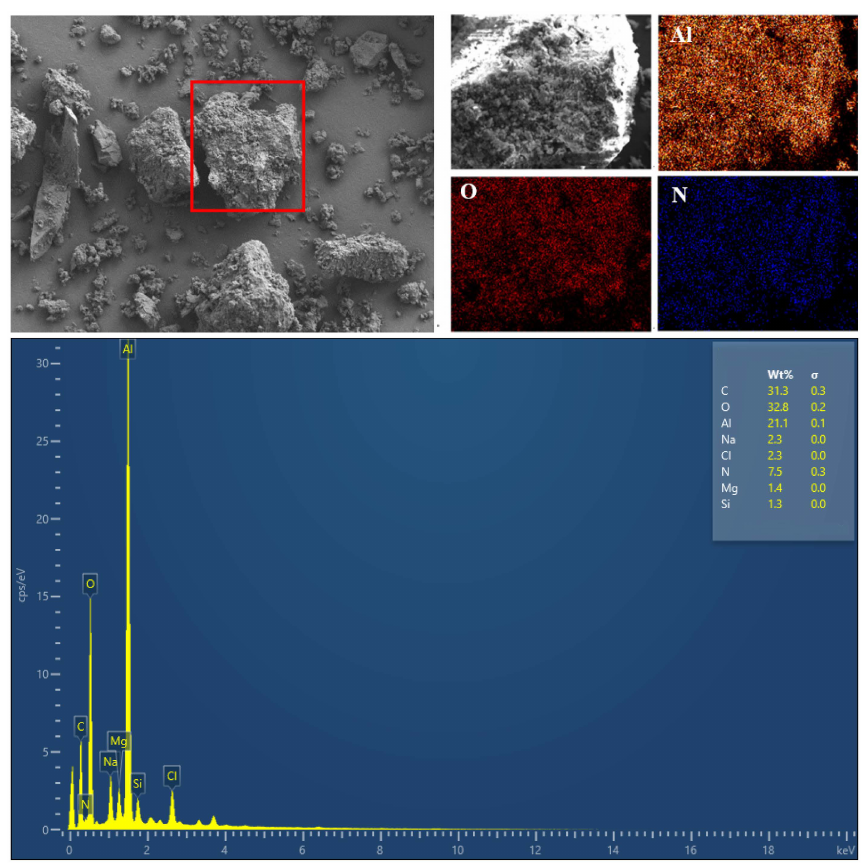
Figure 3. SEM-EDS of the raw material.